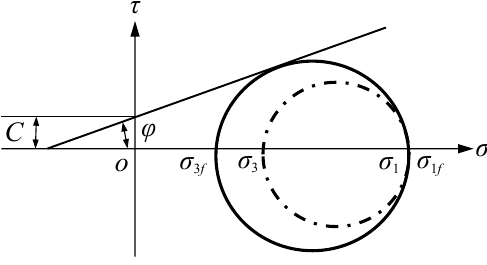
Figure 1. Strength envelope of asphalt concrete triaxial test .